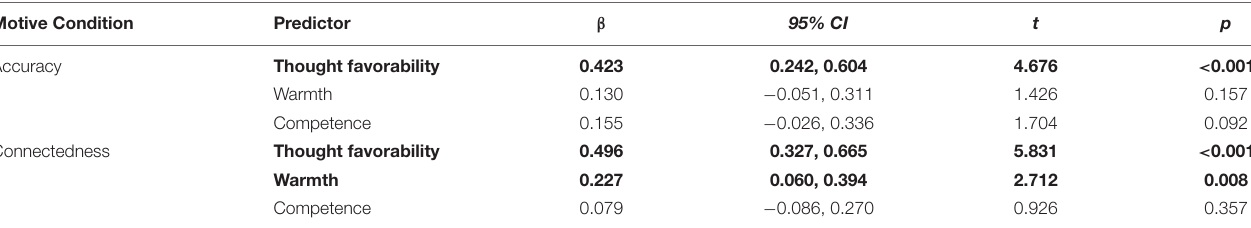
TABLE 2 | Multiple Regression of Product Attitude on Thought Favorability, Perceived Warmth of Source, and Perceived Competence of Source, Reported Separately by Motive Condition, in Study